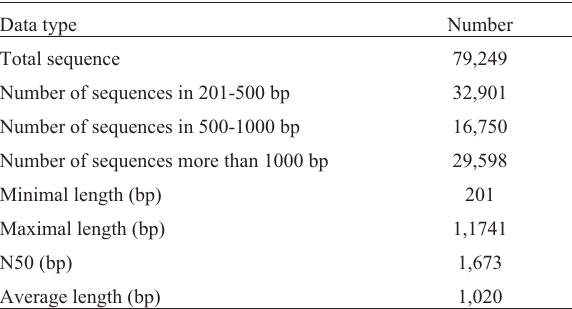
Table 1 - Summary of assembly statistics for the Medicago ruthenica